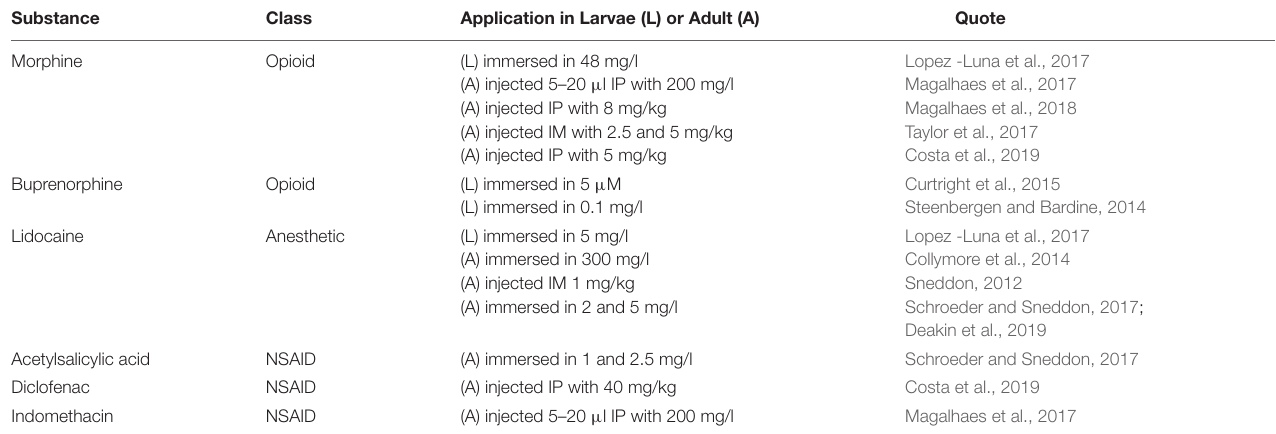
TABLE 2 | Selected analgesics and their effective doses in larvae (L) and adult (A)